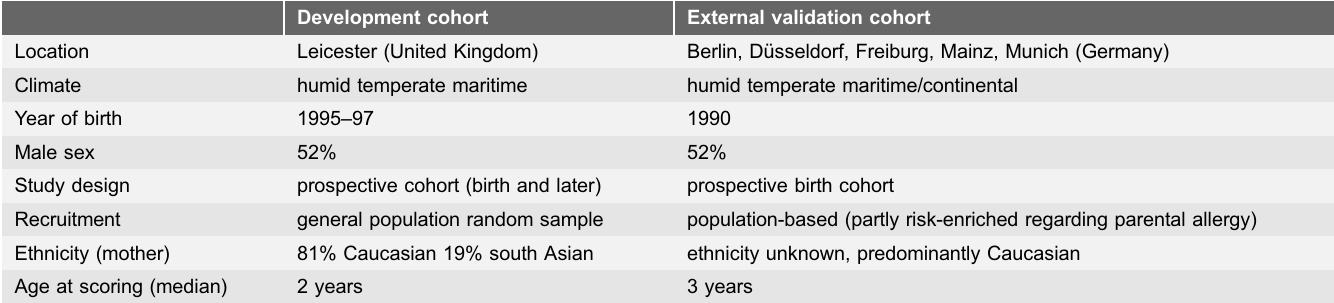
Table 1. Comparison of study characteristics.